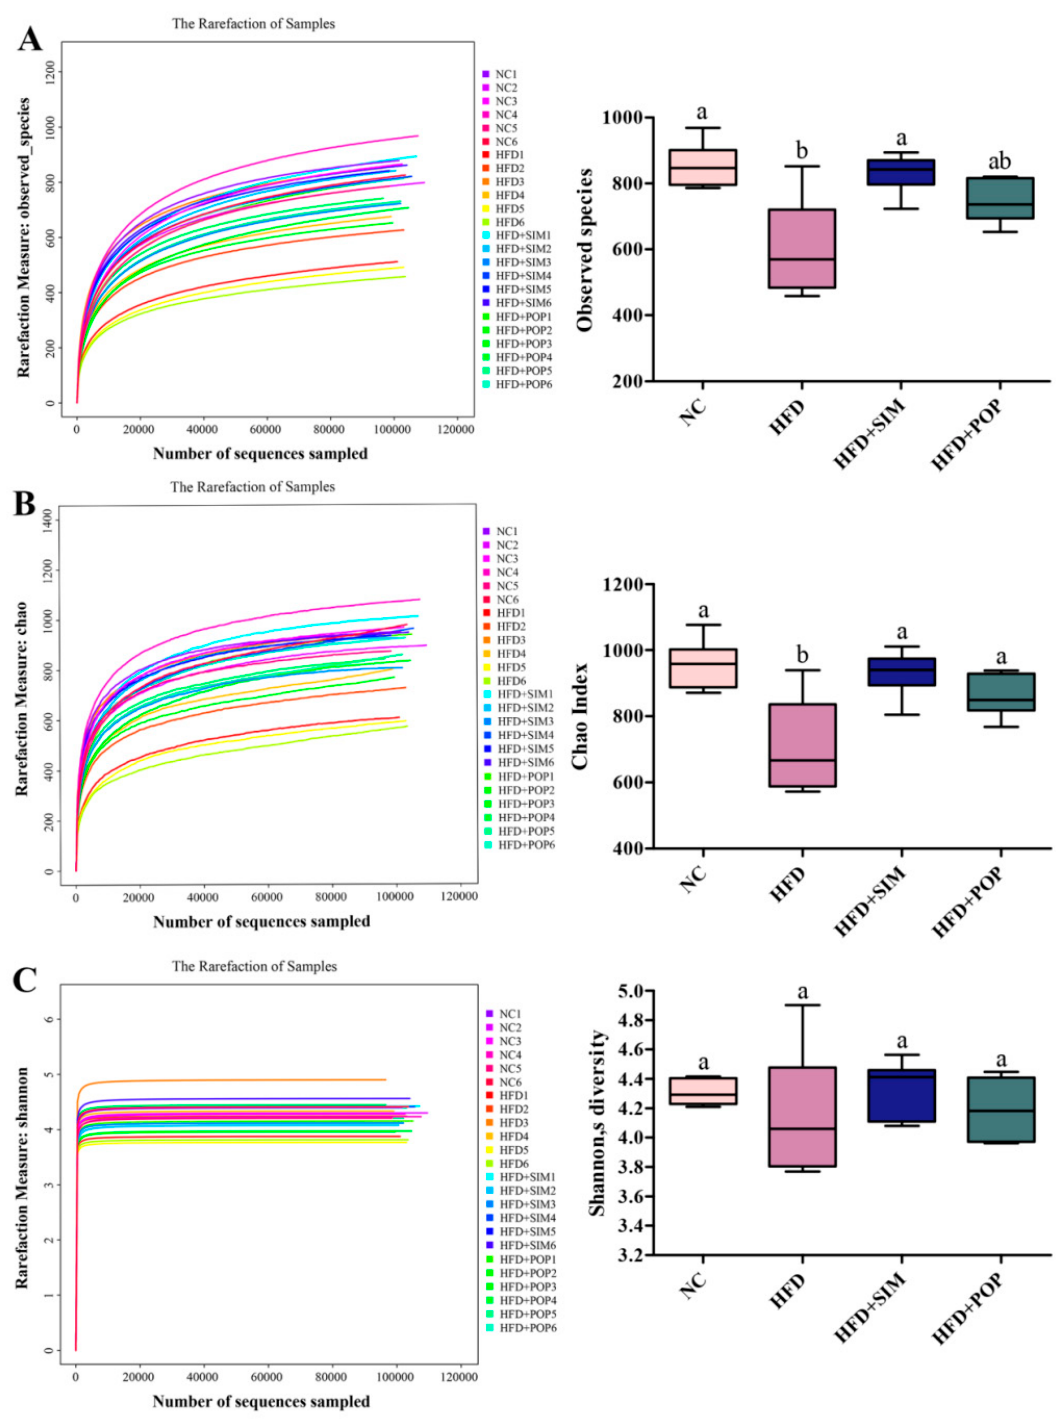
Figure 5. Diversity analysis of gut microbiota from fecal samples of POP-treated obese rats. ( A ) Observed species. ( B ) Chao index. ( C ) Shannon’s diversity. NC = normal control, HFD = high-fat diet, HFD + SIM = HFD with simvastatin (1.8 mg/kg), HFD + POP = HFD with P . odoratum polysaccharides (400 mg/kg). All data are presented as means ± SEM. a,b Mean values not sharing a common superscript were significantly different among the groups ( n = 6 for each) ( p < 0.05).